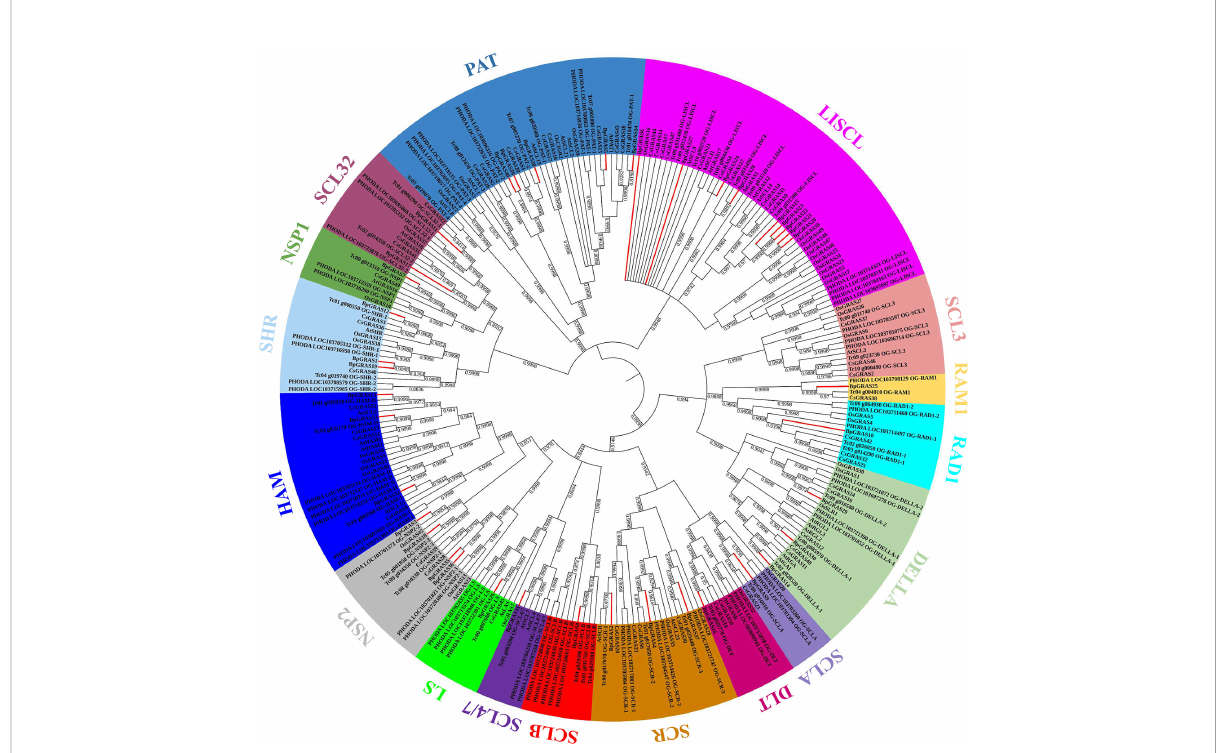
FIGURE 2 Phylogenetic analysis of the BpGRAS proteins and GRAS proteins obtained from Arabidopsis, rice, tea plant, P. dactylifera and T. cacao . Total 265 GRAS proteins obtained from 6 plant species were aligned. The unrooted NJ tree was constructed using MEGA X. All the BpGRAS proteins were emphasized with red